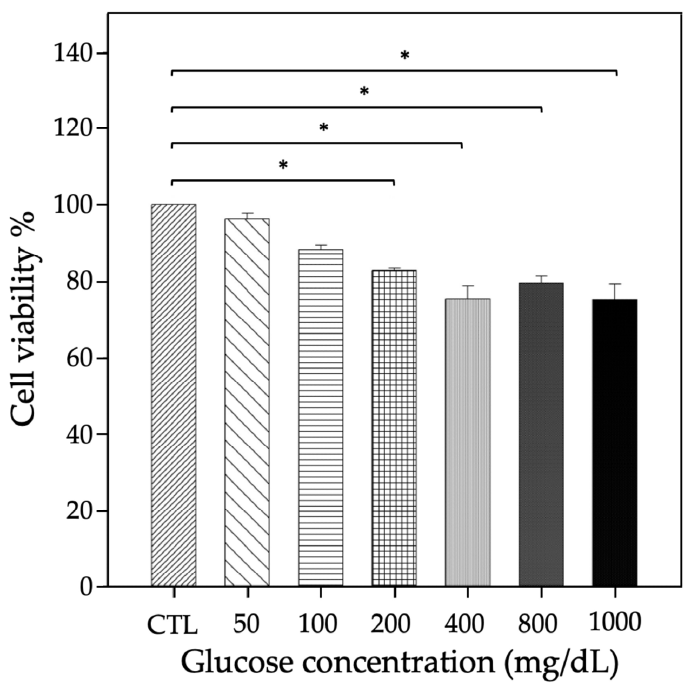
Figure 2. Effect of glucose on the viability of A459 cells (pneumocytes). Cell viability was determined by using the Alamar Blue reagent in cells treated with glucose for 72 h. The different colors in bars represent the control and the concentrations of 50, 100, 200, 400, 800, and 1000 mg/dL of glucose present in the culture medium. There was a decrease in cell viability compared with control cells beginning at 200 mg/dL glucose. The asterisks indicate a statistically significant difference compared to the control group (Dunn’s method); * p ≤ 0.05.